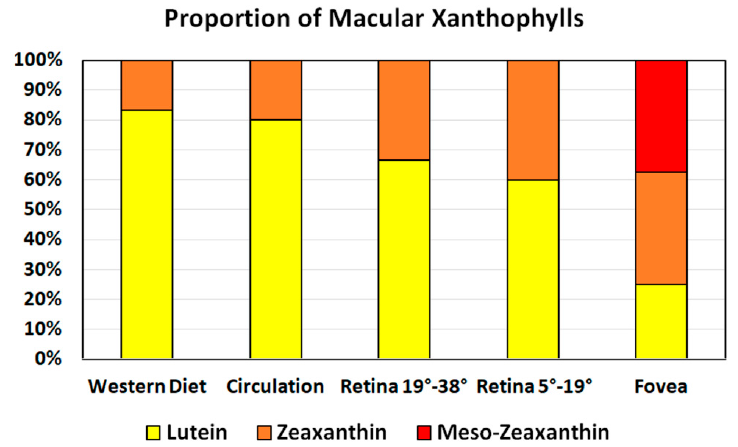
Figure 2. Proportion of major xanthophyll carotenoids in commonly consumed foods, circulation, and retinal areas, showing preferential accumulation of isomers of zeaxanthin in the fovea. Corn and egg yolks contain approximately the same content of both macular carotenoids; the molar ratio of zeaxanthin-to-lutein is about 1 in both foods. Few foods contain more zeaxanthin than lutein. One food with a higher zeaxanthin-to-lutein molar ratio is the orange pepper, with a zeaxanthin-to-lutein molar ratio of approximately 10. Another such food is the fruit of the Lycium barbarum , commonly known as goji berries or wolfberries. Goji berries are the richest source of zeaxanthin (Table 1) and are widely used in traditional Chinese medicine for eye health. Daily